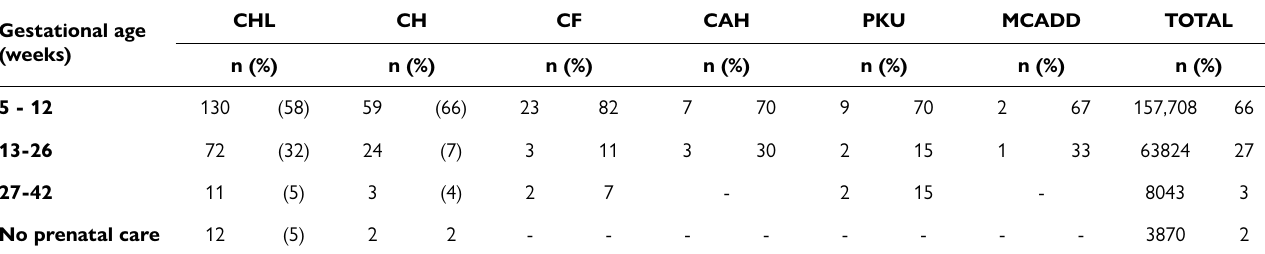
Table 3. Comparison of gestational age at first prenatal care visit in affected newborns detected by Newborn and Infant Screening Programme.